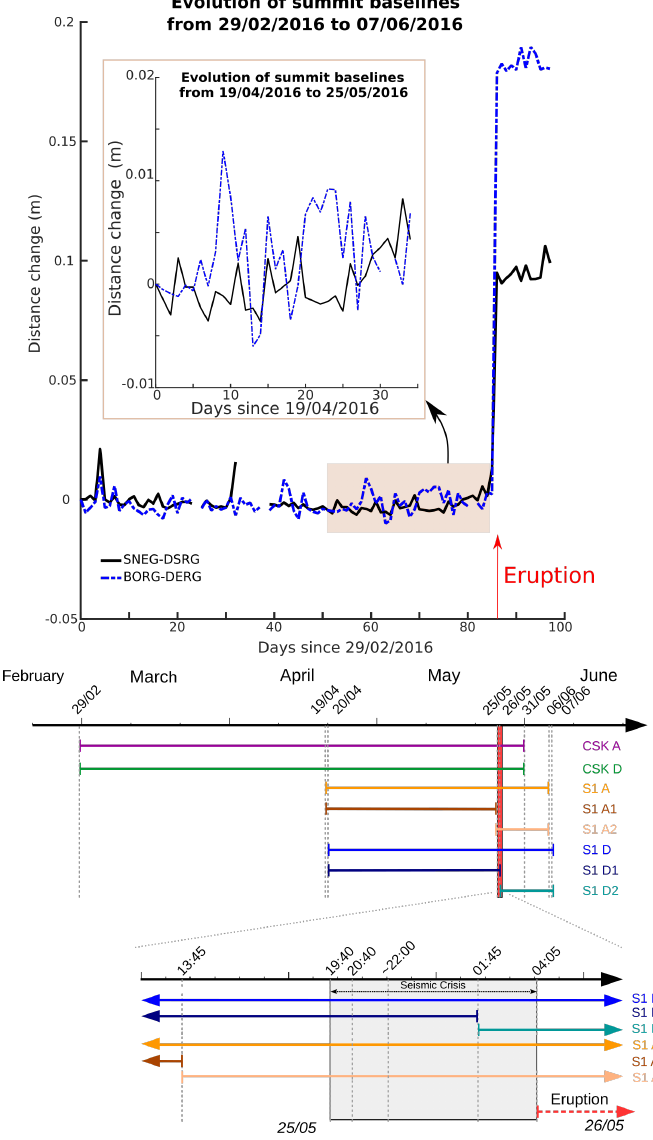
Figure 2. ( Top ) Temporal evolution of baseline changes recorded between two pairs of permanent GNSS stations (SNEG and DSRG and BORG and DERG; see Figure 1 for station locations) between 29